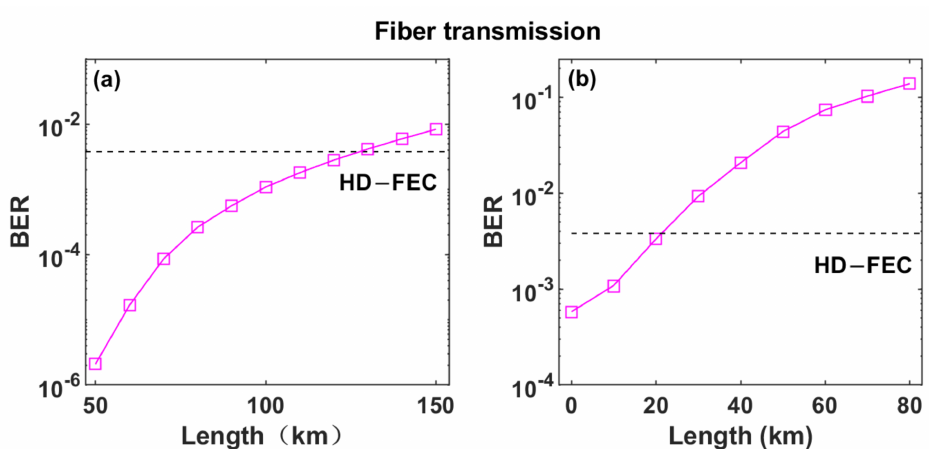
Figure 7. BER as a function of the fiber length for ( a ) Message 1 and ( b ) Message